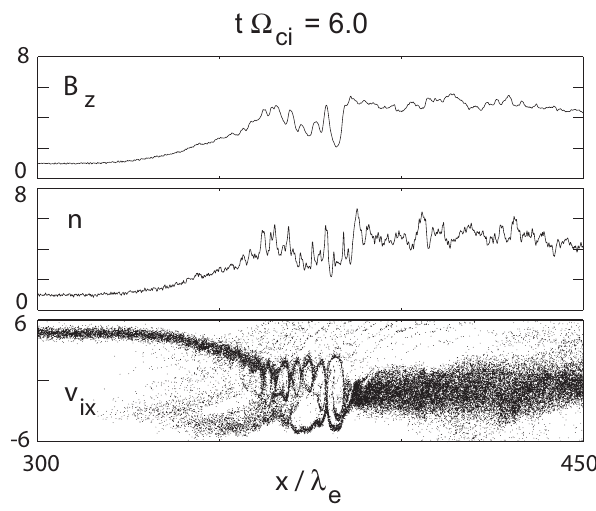
Fig. 3. From top to bottom: magnetic field B z component, ion density n i , and ion v ix phase space versus shock normal direction x for the ion to electron mass ratio 1024